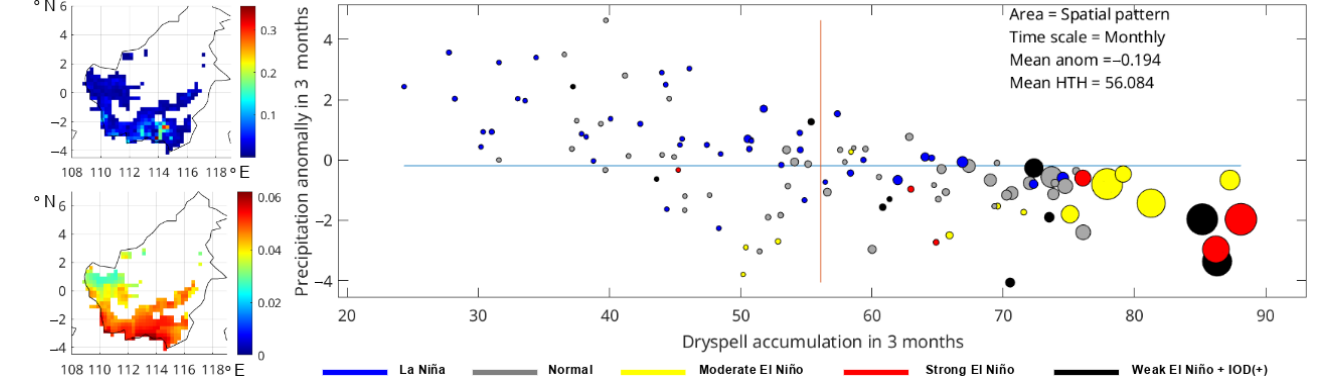
Figure 9. Kalimantan—spatial graph of hotspots ( top ) and dry spells ( bottom ) as well as bubble plot of the monthly fire events for all categories. Blue and orange lines represent average value of respective variables. Size of the bubble represents the number of hotspots for each particular month. Extracted from first mode of SVD with 94.8% of SCF value.